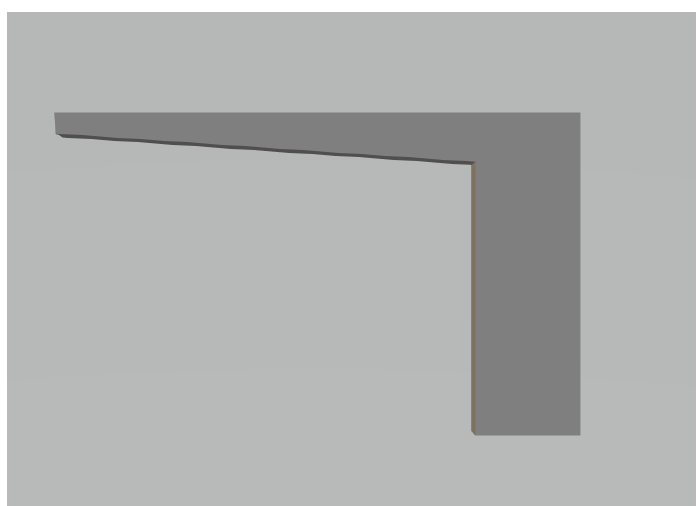
Figure 1. CAD design of the test specimen.